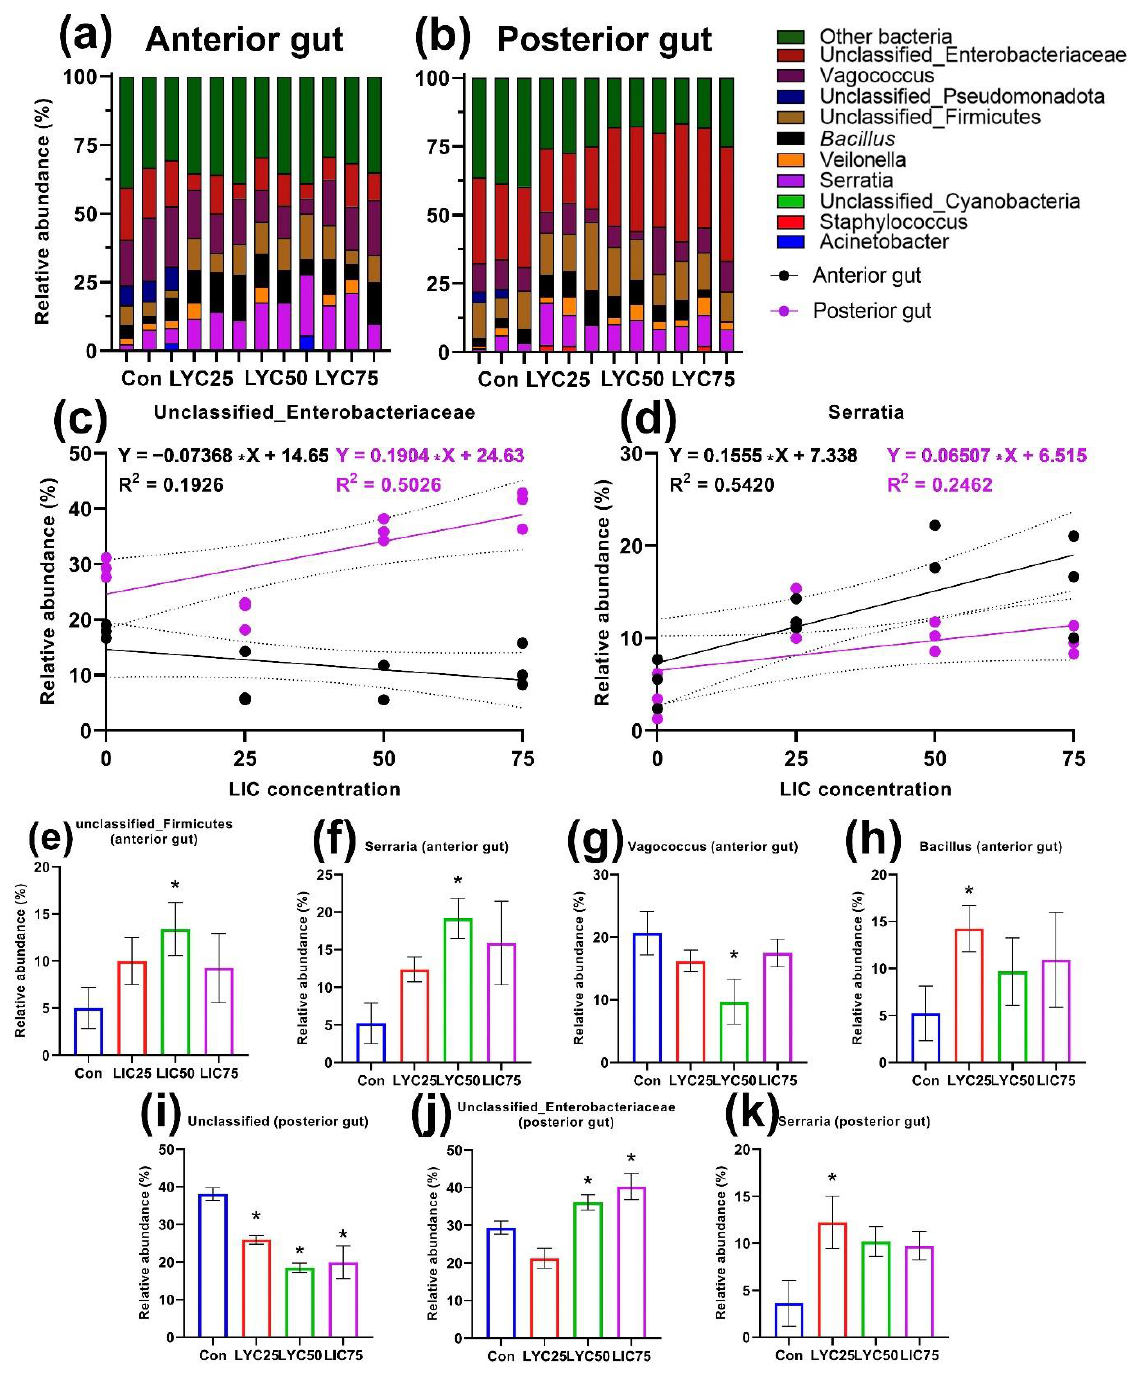
Figure 3. Cultivated microbiota of the anterior and posterior sections of the intestine of experimental groups of D. rerio receiving lycopene ( n = 3). Unclassified bacterial groups are labeled within defined taxonomic groups: ( a , b ) relative abundance of microbiota by bacterial genera in the anterior and posterior intestinal sections, respectively; ( c , d ) linear regression of the relative abundance of unclassified_ Enterobacteriaceae and Serratia in LYC concentration in the anterior (black points) and posterior (purple points) intestinal sections; ( e – k ) relative abundance of different bacterial groups in the control and experimental groups. Value (* — p < 0.05) from the Mann – Whitney test.